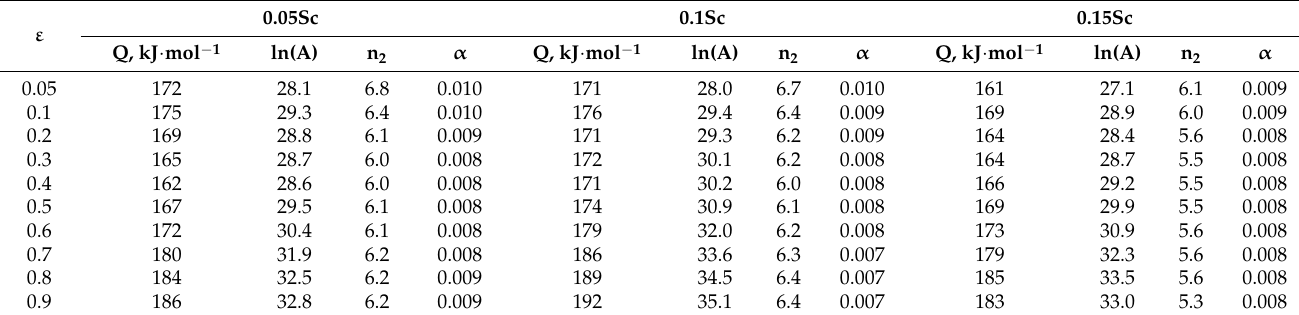
Table 2. The materials constants for the alloy Al4.5Zn4.5Mg1Cu0.12Zr with different Sc contents. ε